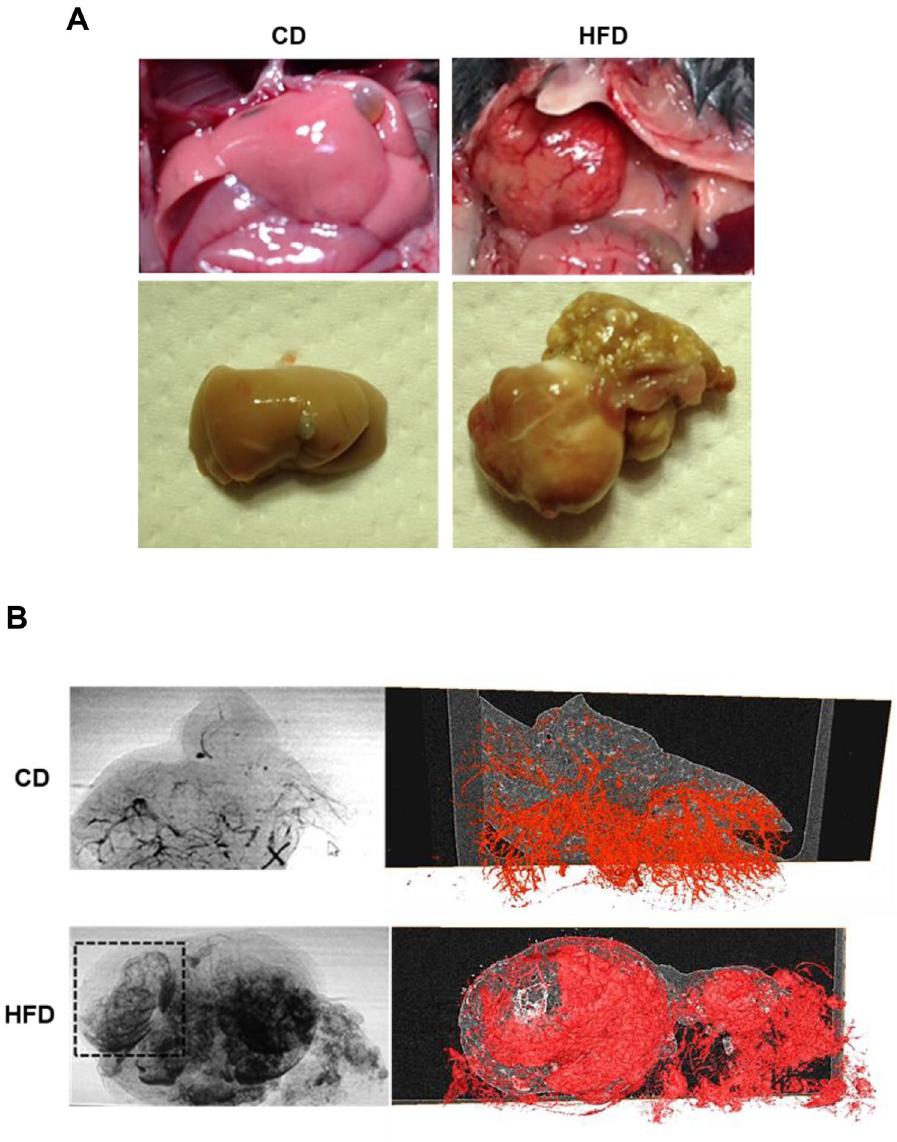
Figure 5. Synchrotron radiation micro-CT images show liver circulation in hepatic tumors and fetal livers. ( A ) Photographs of livers of 33-week-old offspring from CD- or HFD-fed dams (upper panels). Macroscopic images of livers after barium perfusion (lower panels). ( B ) CT fluoroscopy (left panels) and visualization of 3D vessels via synchrotron micro-CT using Amira software (version 1.4.0, https:// www. therm ofish er. com) (right panels) of livers from offspring. The square surrounded by the dotted line shows the typical basket pattern of tumor blood vessels. The computed tomography data from the offspring livers were uploaded to advanced 3D image processing and quantification software (Amira). ( C ) Hematoxylin and eosin staining (upper panels) and phase-contrast micro-CT imaging (lower panels) of livers of offspring at 7 days (CD; n = 7, HFD; n = 9), 4 weeks (CD; n = 6, HFD; n = 9) and 15 weeks (CD; n = 17, HFD; n = 11) of age. Black and white arrows show abnormal vascular structures, including large and thick hepatic arteries, in the livers from offspring of HFD-fed dams. Scale bars: 100 μm. ( D ) Hematoxylin and eosin staining of fetal livers (upper panels. Scale bars: 30 μm). Phase-contrast micro-CT imaging of fetuses (CD; n = 4, HFD; n = 6) at 14.5 dpc from CD- and HFD-fed dams. Scale bars: 1 mm. Hepatic tissue density (ρ) of offspring from CD- and HFD-fed dams. All data are presented as the means ± SD. Measured variables were log(e) transformed for statistical analyses. The significance of the differences between groups was determined using unpaired Student’s t test s. **p <